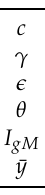
Table 3. Controller